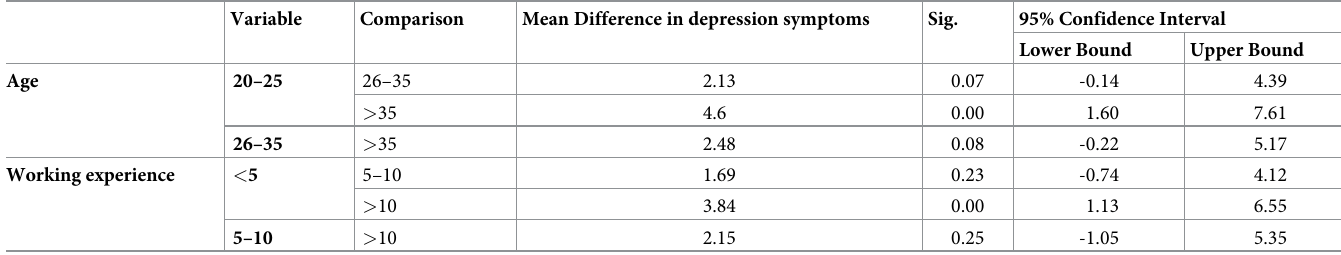
Table 6. Post hoc analysis of age and working experiences